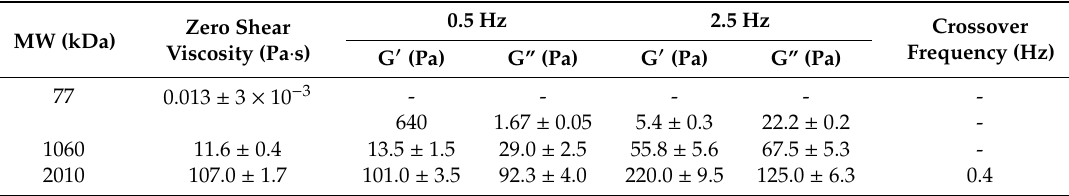
Figure 5. ( a ) The dependency of viscosity on shear rate for hyaluronic acid solutions with different molecular weights; ( b ) the dependency of storage modulus (G ′ ) and loss modulus (G ″ ) on frequency for hyaluronic acid solutions with various molecular weights. Reproduced from [52], with permission from MDPI, 2020. Table 3. Rheological properties of hyaluronic acid solutions [52].